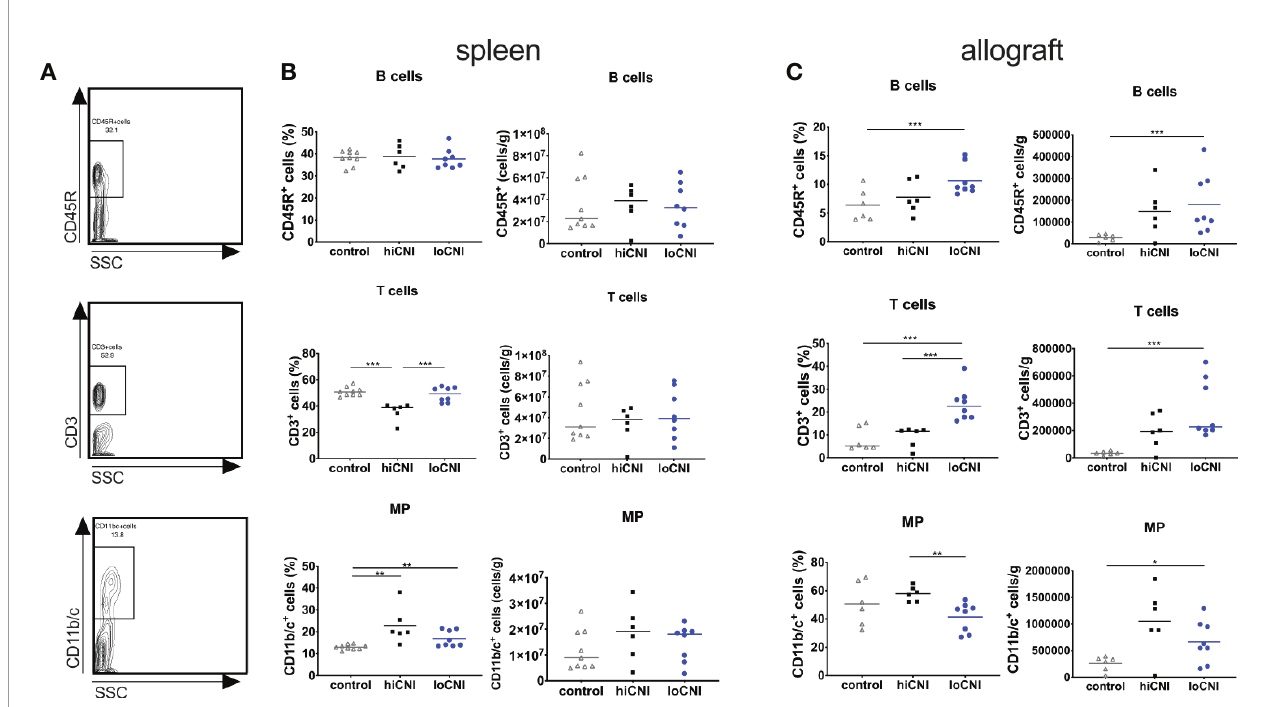
FIGURE 2 | Frequency and absolute numbers of leukocyte subsets in spleens and allografts. Representative fl ow cytometry data (A) , frequency and absolute numbers of B cells (CD45R + ), T cells (CD3 + ) and mononuclear phagocytes (MP, CD11b/c + ) in spleen (B) and allografts (C) measured by fl ow cytometry and shown as percentages of leukocytes or absolute numbers per weight. Means and individual data points are shown from controls (LEW spleen n=9, BN kidneys n=6), hiCNI (n=6) and loCNI (n=8); statistical signi fi cance between groups is shown as *p ≤ 0.05, **p<0.01 and